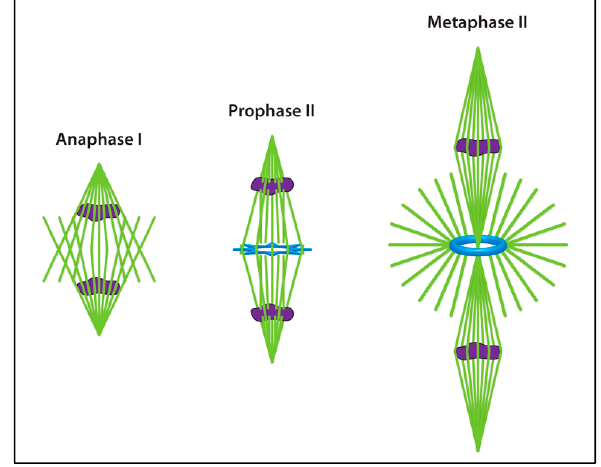
Figure 3. A non-centrosomal microtubule organizing center (ncMTOC) assembles during meiosis II. Meiosis I spindle assembly is anastral, but in late meiosis I a central aster forms, comprised of centrosomal PCM proteins, that separates the two meiosis II spindles. The blue structures represent the central aster ncMTOC; MTs are green; DNA is purple. Figure based on [152]. The proteins necessary for formation of the central aster of meiosis II have come into focus. Mutations in polo [164], cnn [152], mud [163], or the γ -TuRC components grip75 or grip128 [165] block assembly of the central aster, resulting in separation of the two spindles at meiosis II and aberrant spindle organization. For a detailed review of Drosophila female meiosis see [166]. Successful completion of meiosis generates four haploid nuclei, one of which joins with the haploid sperm nucleus at fertilization.